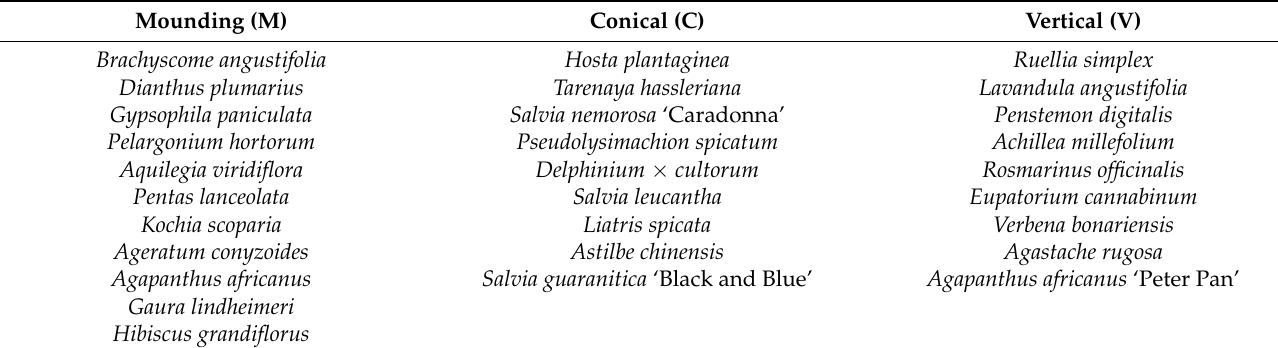
Table 1. Classification of selected species in terms of plant